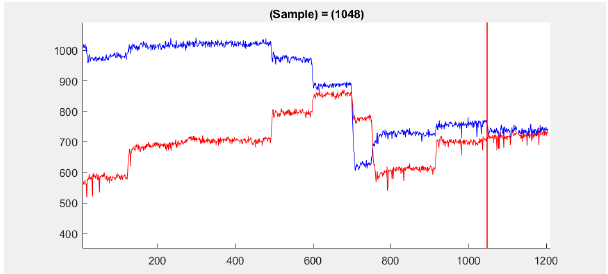
Figure 10 . Position plot for dataset 2.2 at sample 1048 (red line at sample 1048) shows a small jump in the mean. The small jump is detected in spite of significant noise.